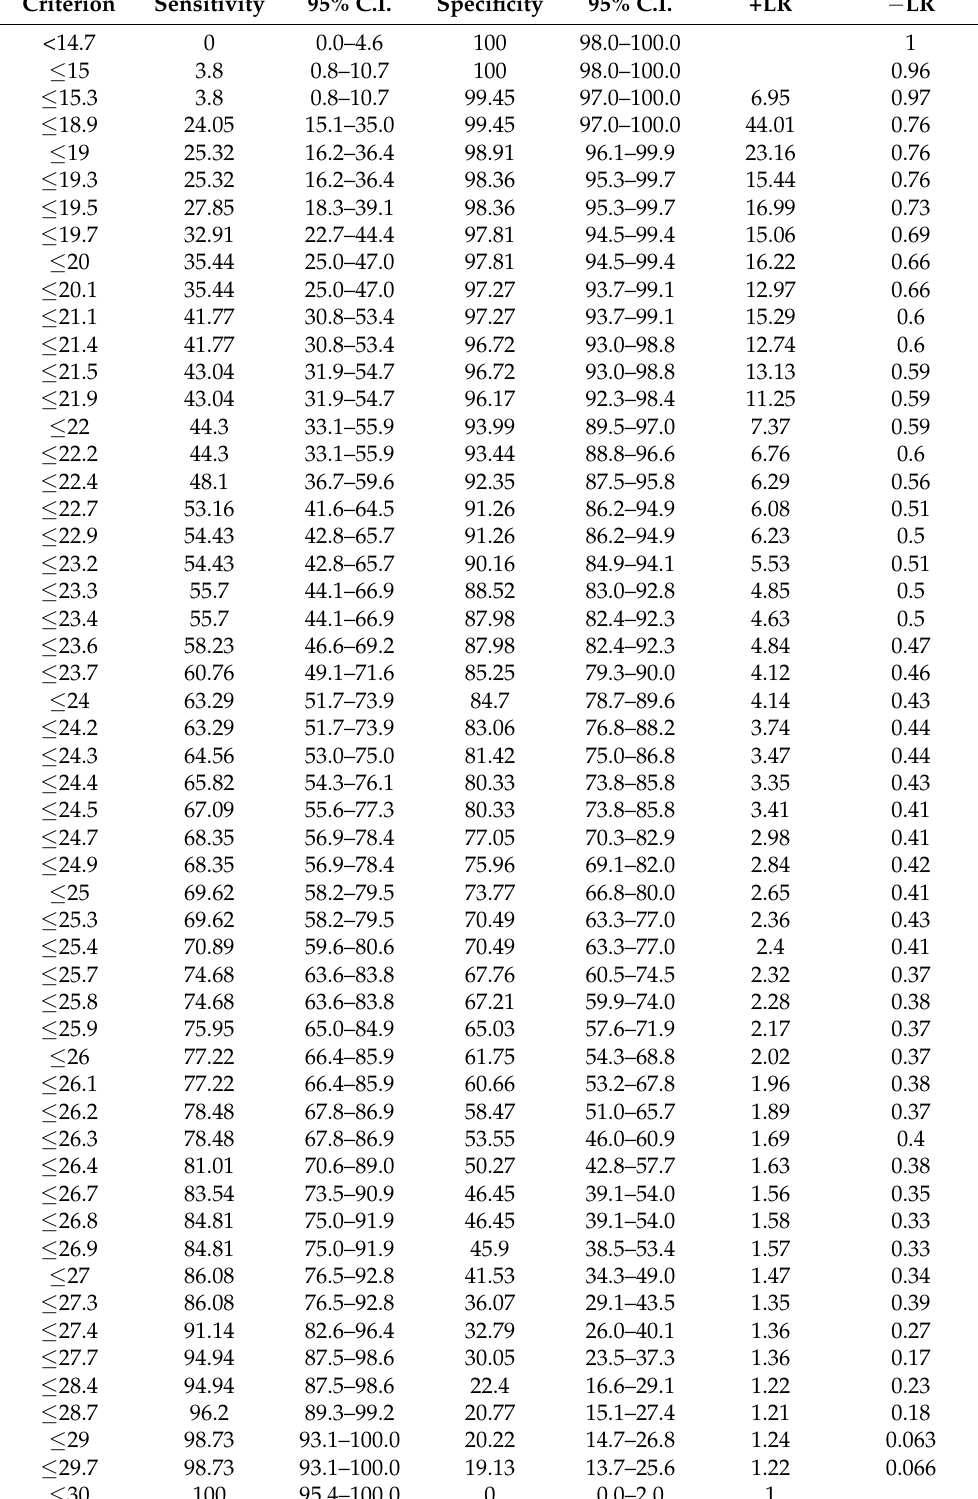
Table 3. Criterion values and coordinates of the ROC curve (severe